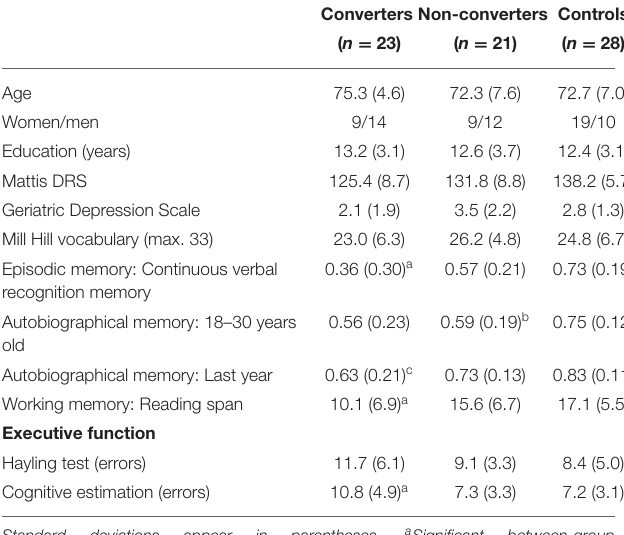
TABLE 1 | Demographic, clinical, and neuropsychological characteristics of the converters, non-converters, and control groups. Converters Non-converters